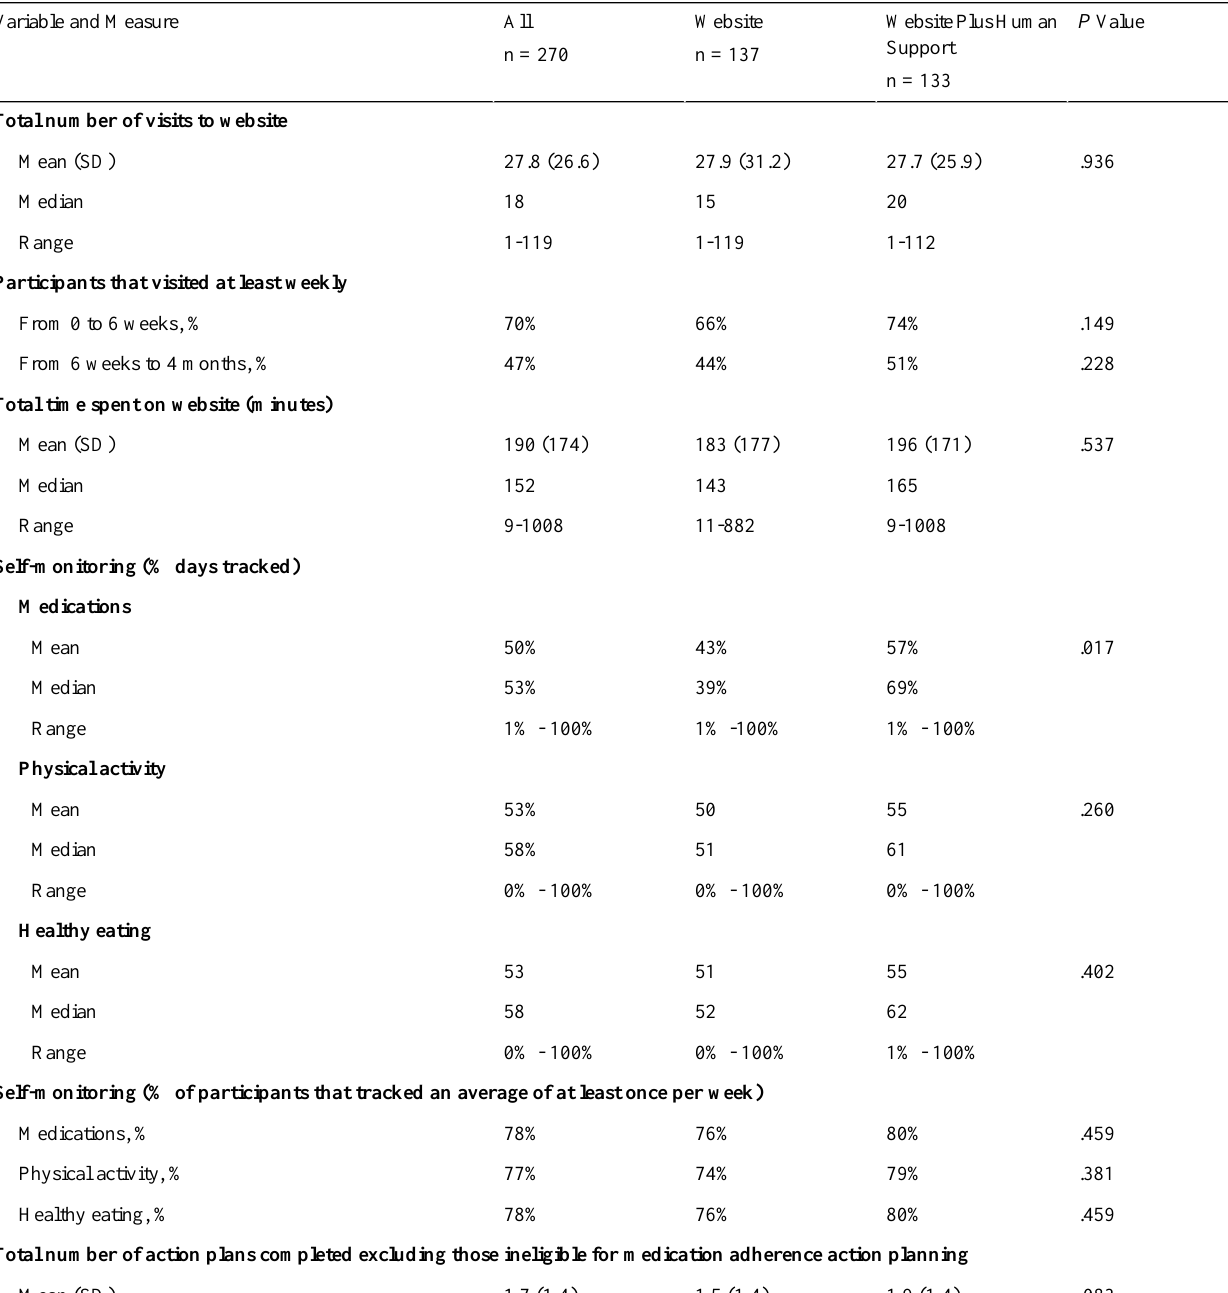
Table 2. Website usage (0 to 4 months) overall and by treatment condition